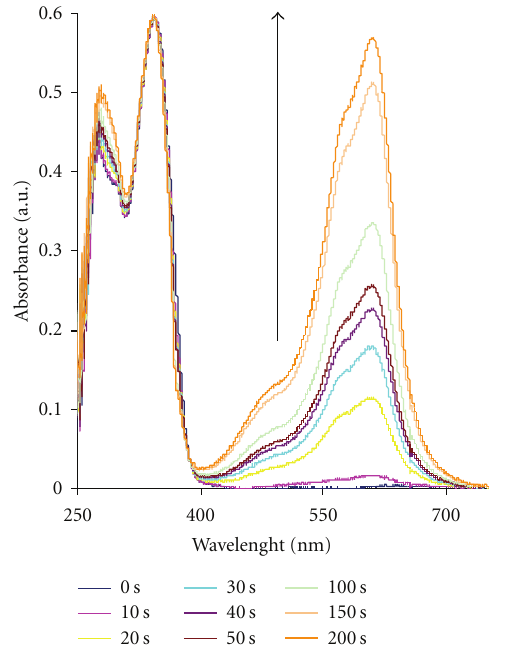
Figure 3: Absorption spectra of SPO-7OH in P(MMA-BMA) — thermal relaxation process at 303 K.